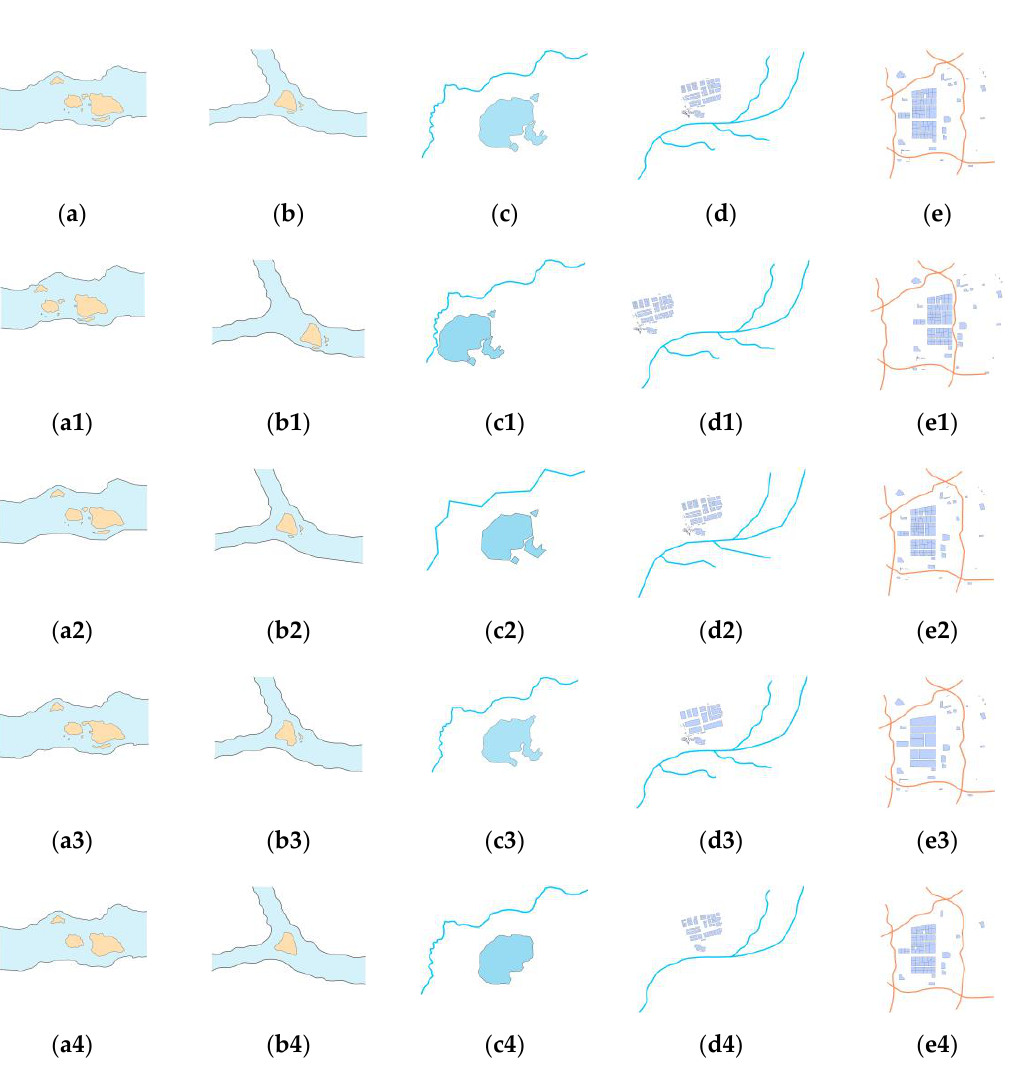
Figure 15. Original data and generalization data: ( a – e ) the original data; ( a 1 – e 1) the data after the displacement operation; ( a 2 – e 2) the data after the simplify operation; ( a 3 – e 3) the data after the merge operation; and ( a 4 – e 4) the data after the delete operation.